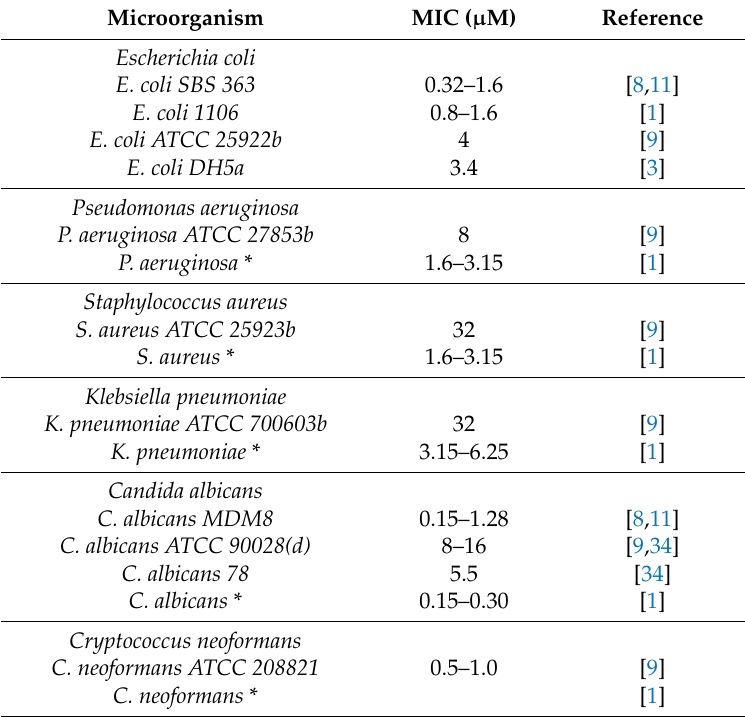
Table 1. Anti-microbial activity of Gm for the most commonly tested microorganisms. MIC values from different studies are combined unless they are significantly different from each